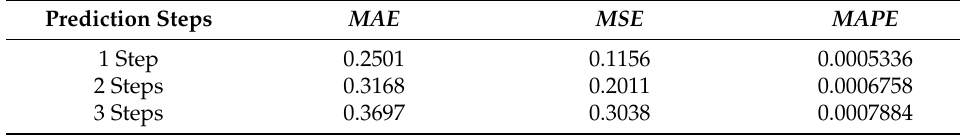
Figure 9. Comparison of the results of different prediction steps. Table 7. Evaluation metrics for different prediction steps.